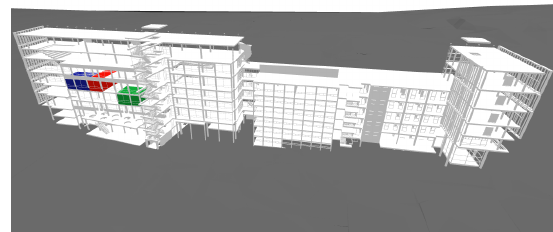
Figure 10. Visualisation of above query via QGIS. Query results include 3035 painted in red, 2035 in green and 3034 in